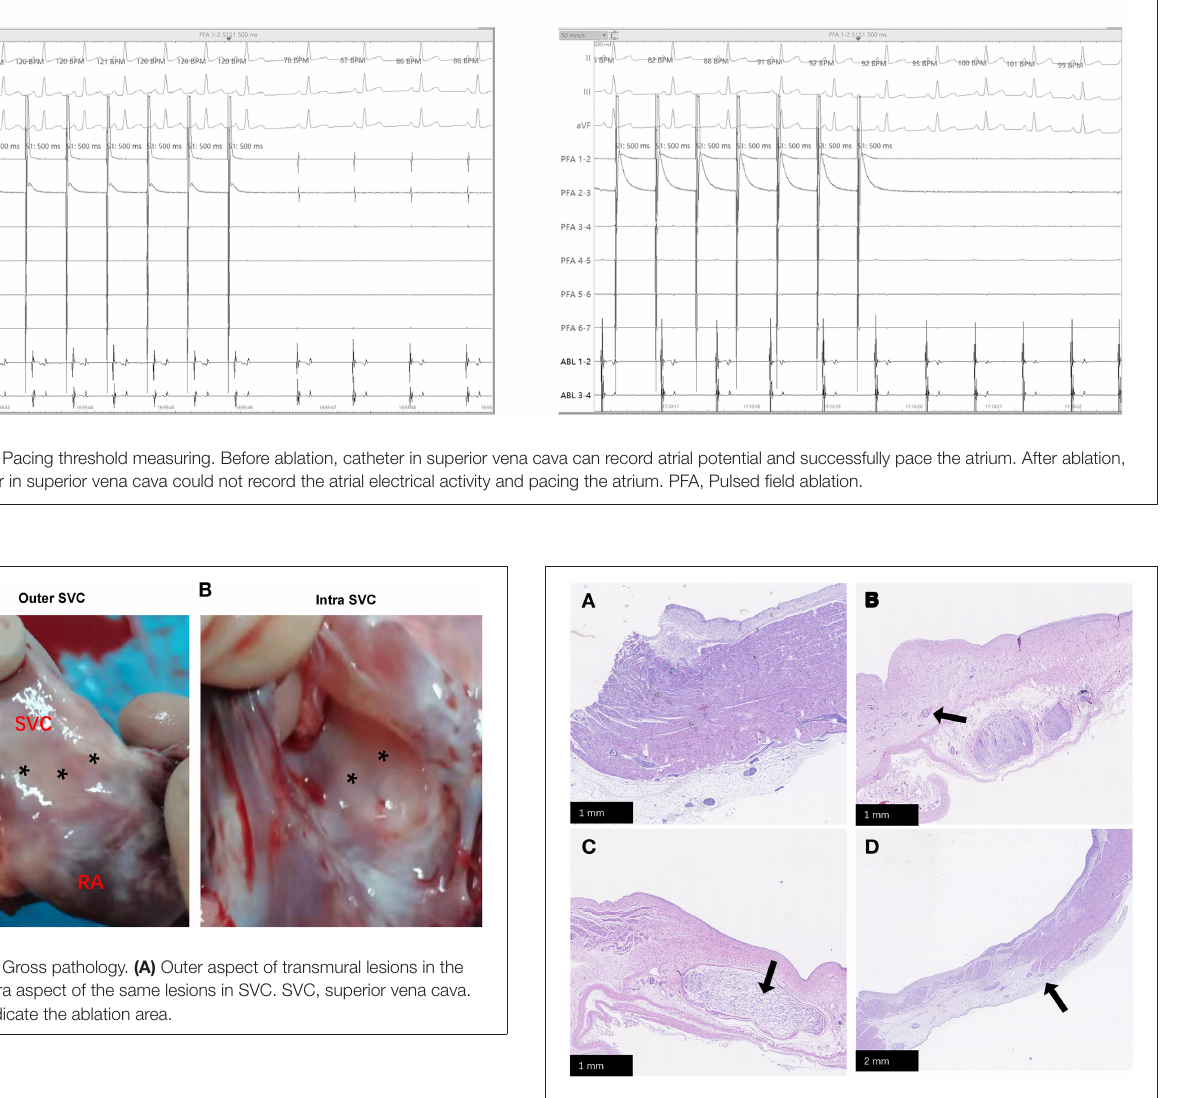
FIGURE 6 | HE staining. (A) Normal SVC tissue; (B) Transmural damage caused by PFA, the arrow points to the reserved vascular structure; (C) The arrow points to the reserved nerve tissue; (D) The arrow points to the position of edge of PFA damage. PFA, pulsed field ablation. SVC, superior vena